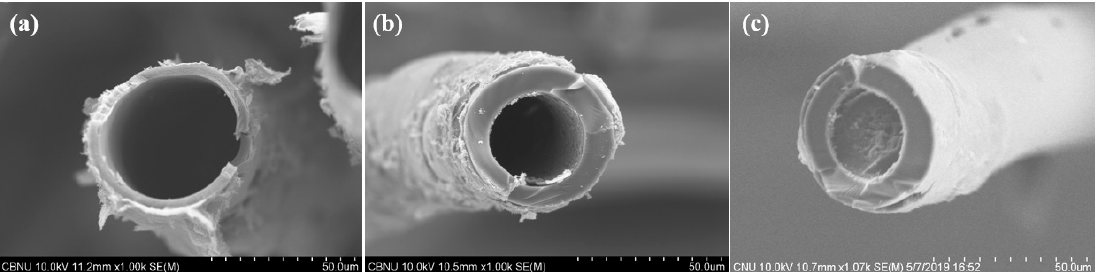
Figure 13. Cross section SEM images after carbonization and activation of the sulfonated LDPE/HDPE sheath-core fibers for time of 60–120 min under 0.25 MPa at 130 °C: ( a ) 60 min; ( b ) 90 min; ( c ) 120 min.